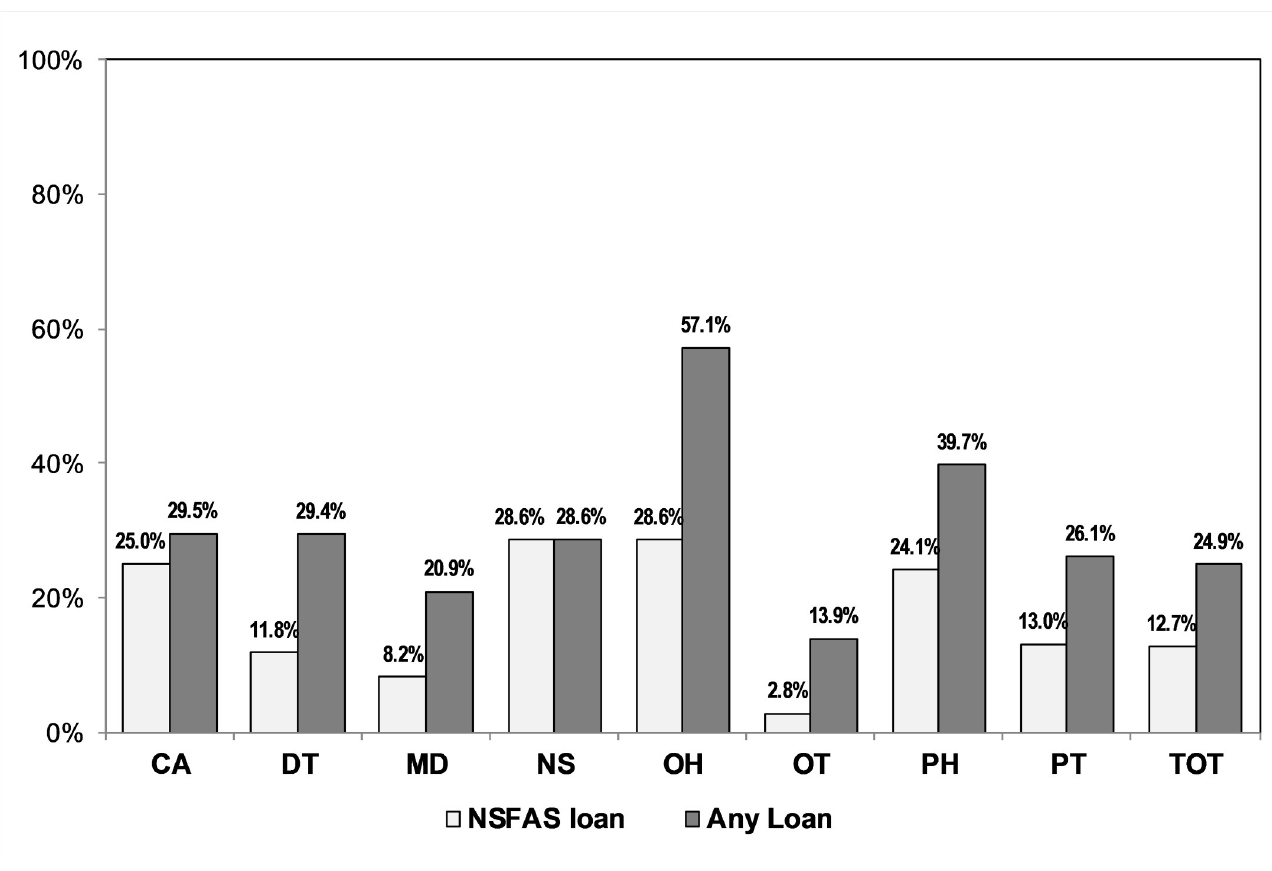
Fig 2. Loan financing of studies of WISDOM cohort members. CA = clinical associate; DT = dentist; MD = medical doctor; NS = nurse; OH = oral hygienist; OT = occupational therapist; PH = pharmacist; PT = physiotherapist; NSFAS = National Student Financing Aid